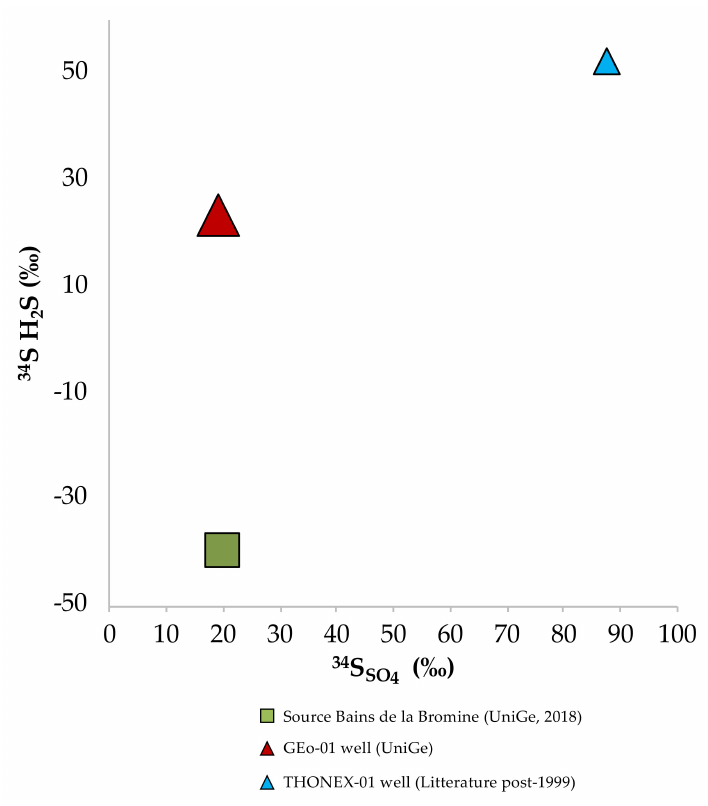
Figure 9. δ 34 S isotope SO 4 vs. 34 S in